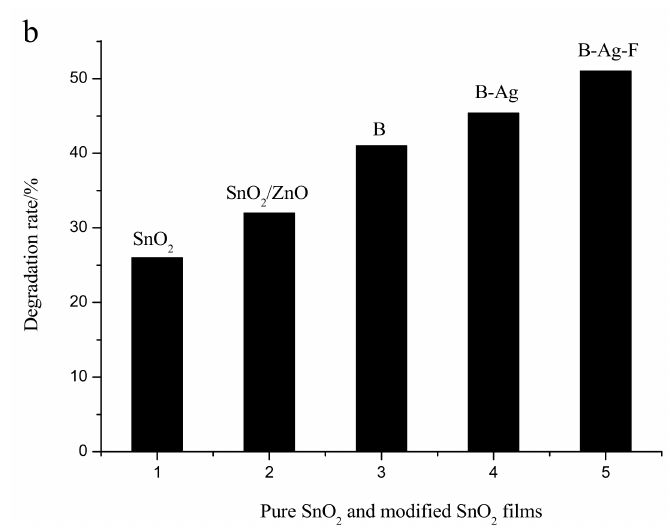
Figure 1. The ( a ) ultraviolet–visible absorption spectra and ( b ) degradation percentage of the methyl green (MG) solutions using pure SnO 2 , SnO 2 –ZnO, B doped SnO 2 –ZnO, B/Ag di-doped SnO 2 –ZnO, and B/Ag/F tridoped SnO 2 –ZnO films under UV irradiation for 45